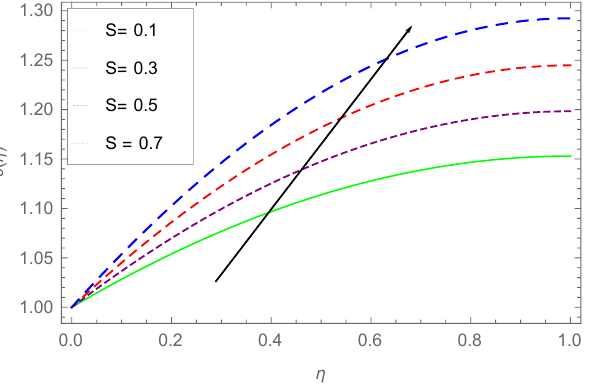
Figure 8. Impact of S on θ ( η ) , when Nb = 0.5, (cid:101) = 0.5, β = 1.0, Nt = 0.3, Sc = 0.9, Pr =